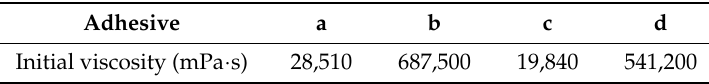
Table 3. The viscosity of the adhesives: ( a ) SF adhesive; ( b ) SF/LB adhesive; ( c ) SF/PAE adhesive; and ( d ) SF/LB/PAE